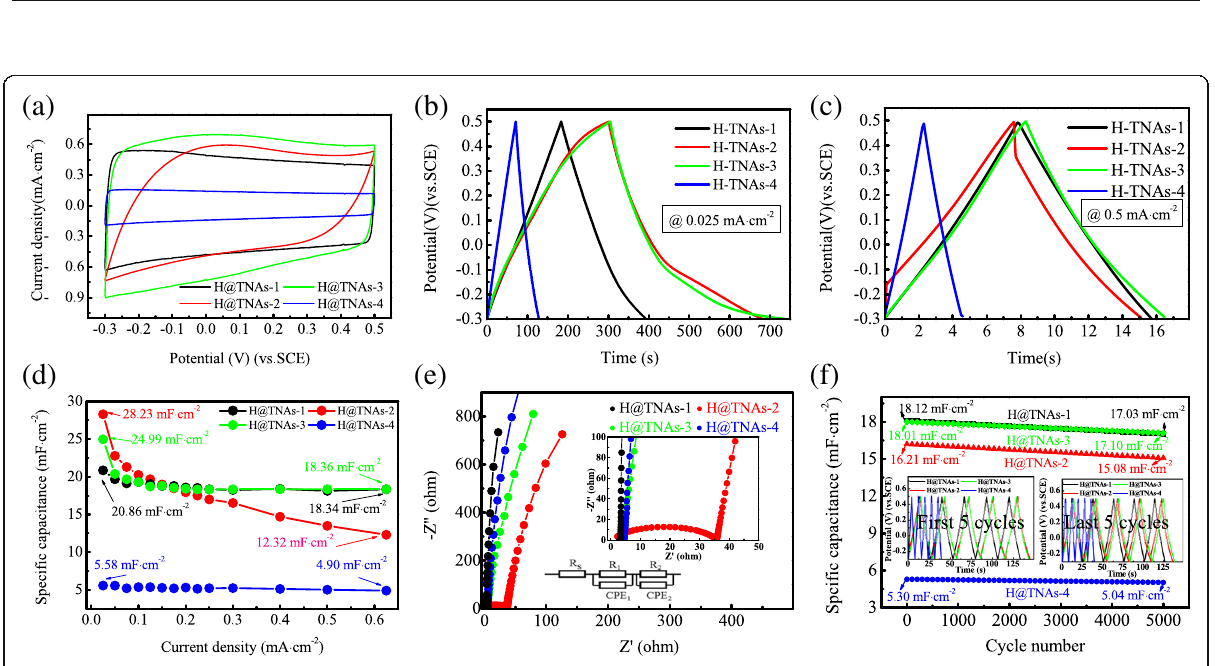
Fig. 10 a TEM image of H@TNAs-2. b Corresponding SAED patterns of the dotted area in a. HR-TEM images of c H@TNAs-3. The inner diameters of all samples are ~ 70 nm, regardless of the annealing temperature